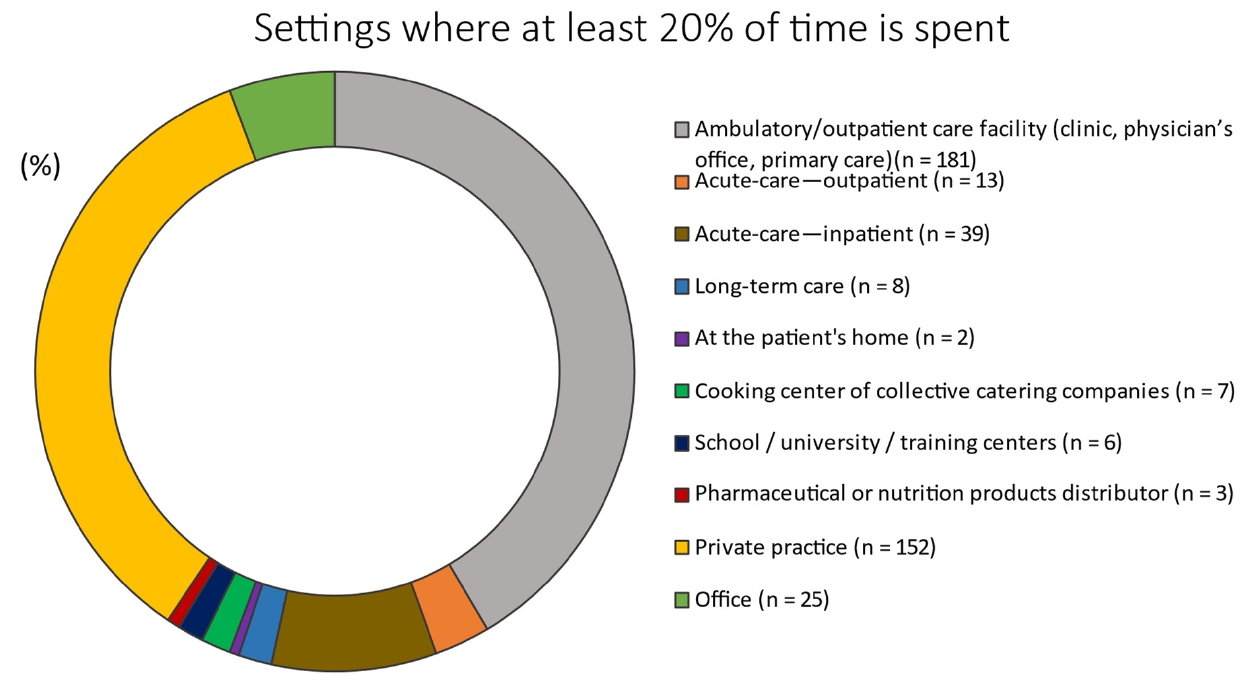
Figure 3. Setting where at least 20% of the time is spent ( n = 436) . Before the COVID ‐ 19 pandemic, Italian RDNs typically delivered face ‐ to ‐ face ser ‐ vices for a mean of 22.3 ± 12 h per week (range, 1 to 55), and only 16.1% ( n = 70) provided nutrition care via telehealth (Table 2 and Figure 4). However, this proportion increased significantly to 63.1% ( n = 275) at the time the survey was completed ( p < 0.001) (+293%